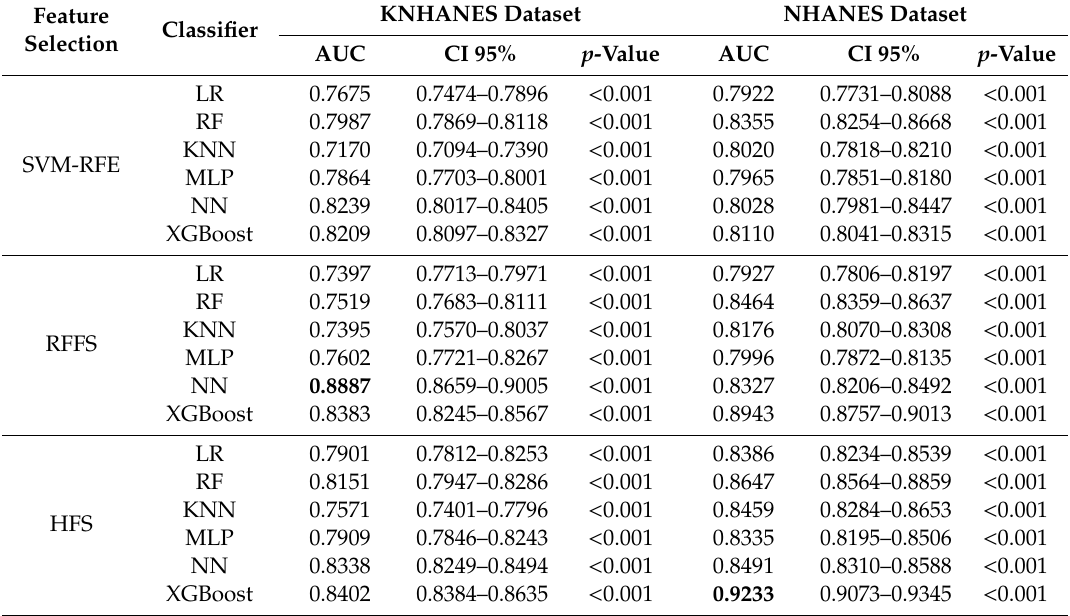
Table 4. Statistical significance test of the area under the curve results for predictive models in the KNHANES and NHANES